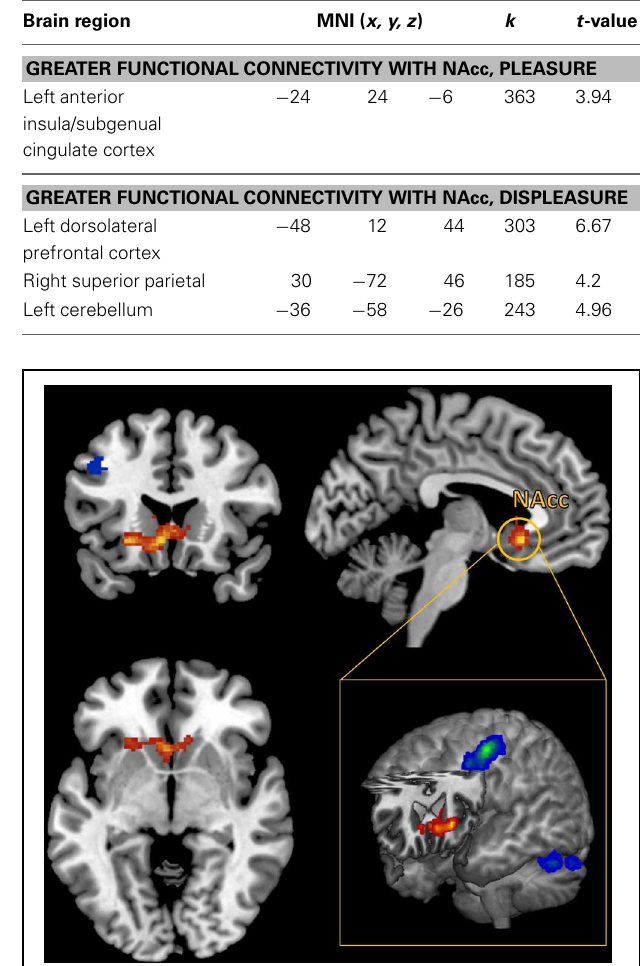
FIGURE 2 | Relationship between participant’s reports of pleasure from watching MMA and percent signal change in the nucleus accumbens (MNI coordinates: ± 10, 12, − 2). Each point corresponds to a single subject’s percent signal change on the X axis and self-reported pleasure or displeasure rating on the Y axis.